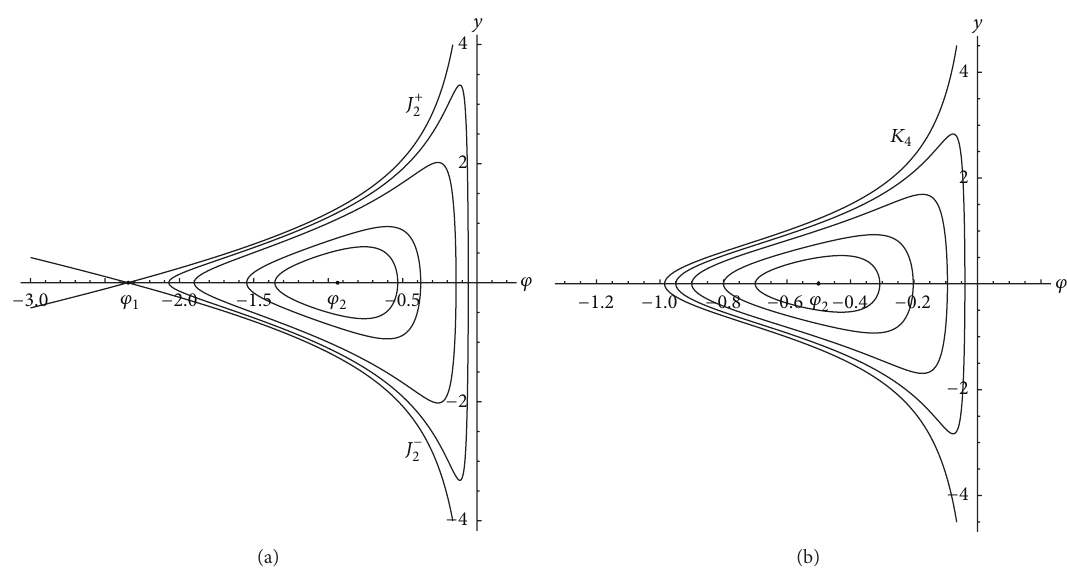
Figure 3: The periodic orbits surrounding the center point (𝜑 2 , 0) and their boundaries, where (a) for Case 4 and (b) for Case 5.